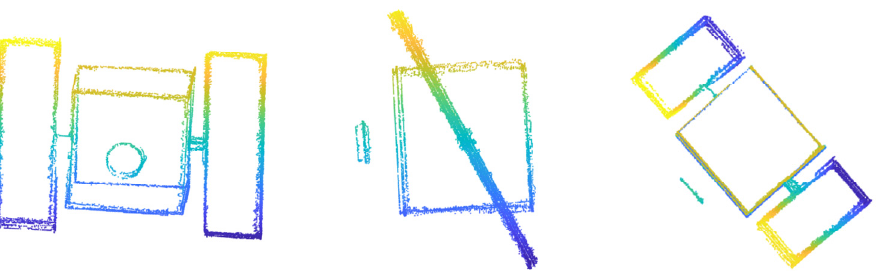
Figure 7. Simulated point cloud contour model.